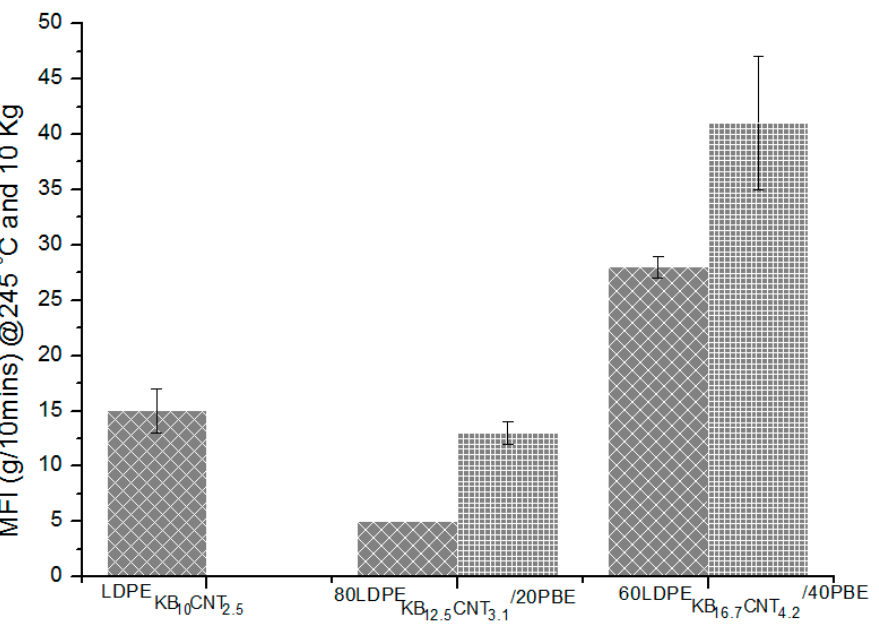
Figure 22. MFI (g / min @ 245 ◦ C / 10Kg) of the conducting biphasic blends using 1-step ( Figure 25. Strain (%) of the conducting biphasic blends produced by a 1-step ( ) or 2-step Figure 25. Strain (%) of the conducting biphasic blends produced by a 1-step ( ) or 2-step Figure 22. MFI (g/min @ 245 °C/10Kg) of the conducting biphasic blends using 1-step ( )or 2- ( ( ) extrusion 3D-printed onto textile materials in the cross ( a ) and machine ( b ) directions of the ( ) extrusion 3D-printed onto textile materials in the cross ( a ) and machine ( b ) directions of the step ( ) extrusion. fabric.